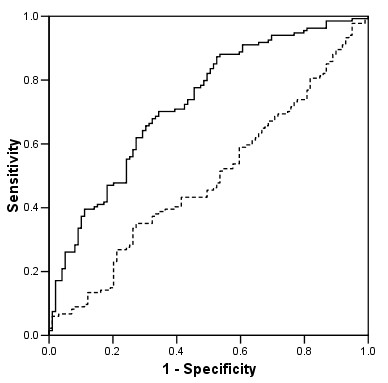
Prediction of the epoetin dose required to reach the haemoglobin target. ROC curves plotting sensitivity against 1 minus specificity for a epoetin dose cut-off of 100 IU/Kg/week in the prediction of the dose required for an individual patient to reach the haemoglobin target of 11.5 g/dL obtained from the best performing linear regression (dotted line; using as input variables weight and ferritin) and the best performing ANN (continuous line; using as input variables weight, age, presence or absence of an impaired left ventricular ejection fraction, serum creatinine and ferritin). The areas under the curves, the 95% confidence intervals and the significance P for the linear regression and the ANN were respectively: 0.491 (0.416–0.565), P:n.s. and 0.728 (0.663–0.794), P < 0.001 (P < 0.001 for the difference between the two curves).